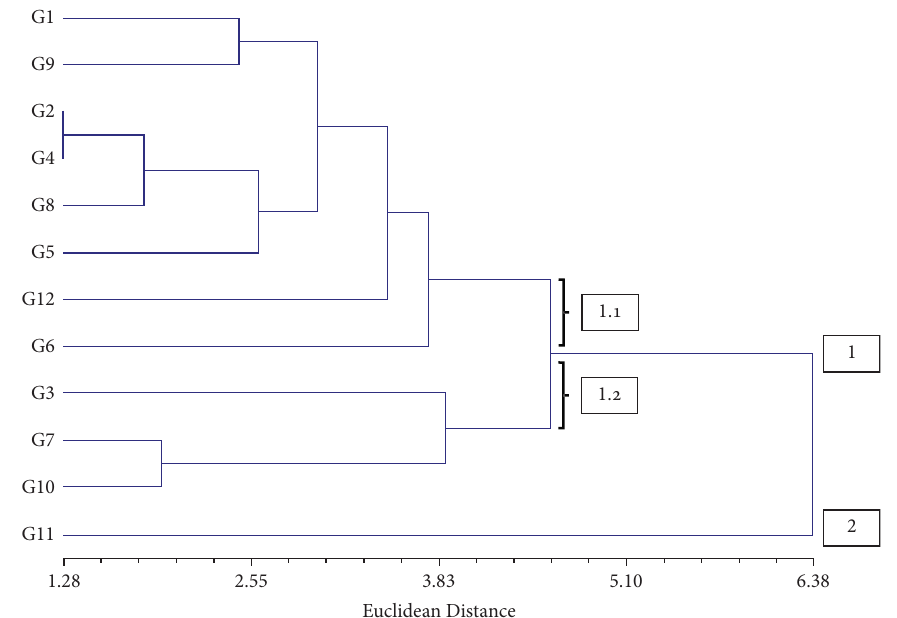
Figure 7: Dendrogram for nine genotypes of PFSP and three commercial varieties as checks based on agronomic traits in